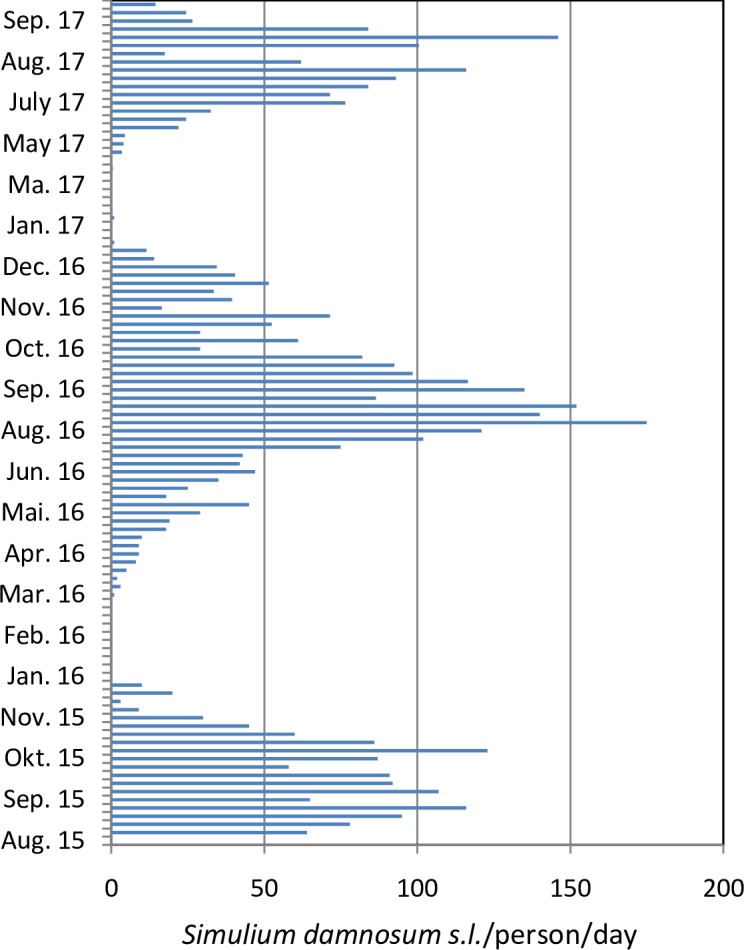
Collection of Simulium damnosum s.l. at the catch point at the Mô river (village of Bouzalo) caught per person (one day per week).The annual biting rate (ABR) from January 2016 until December 2016 was calculated by multiplying the number of blackflies caught daily by the number of days per week for each month to add up to 12 months. Collections were conducted from 7am to 6pm with alternating fly catchers every two hours as described in Material and Methods.